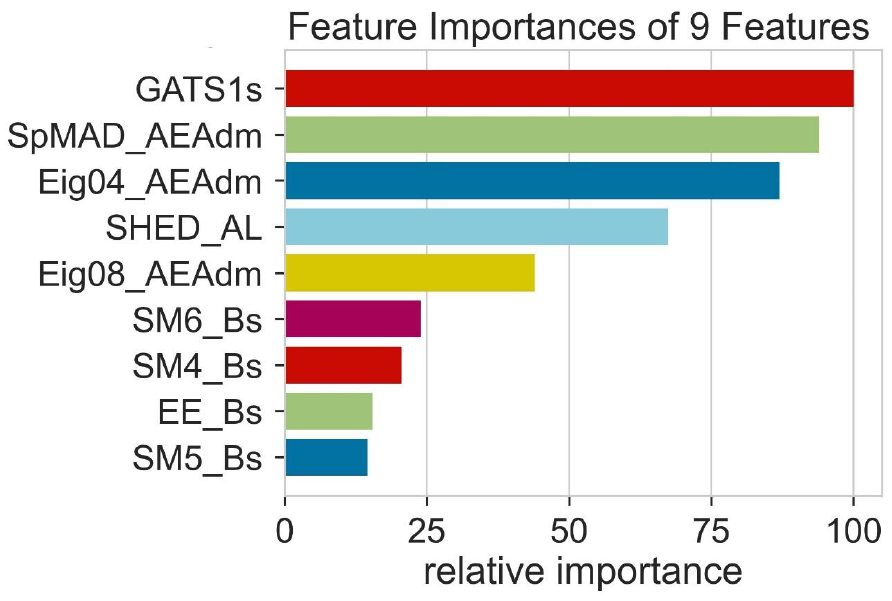
Figure 12. The relative importance of features.